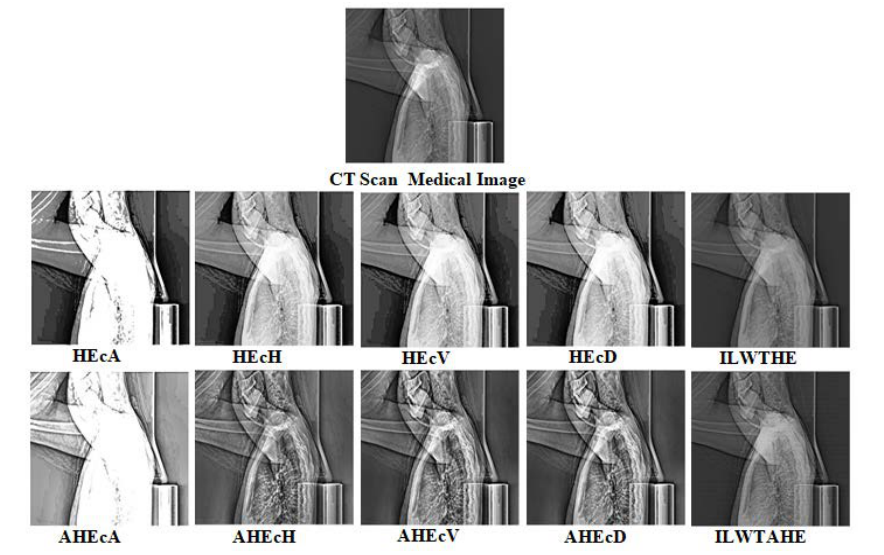
Fig.2: Enhanced CT Scan images for all coefficients used HE and AHE